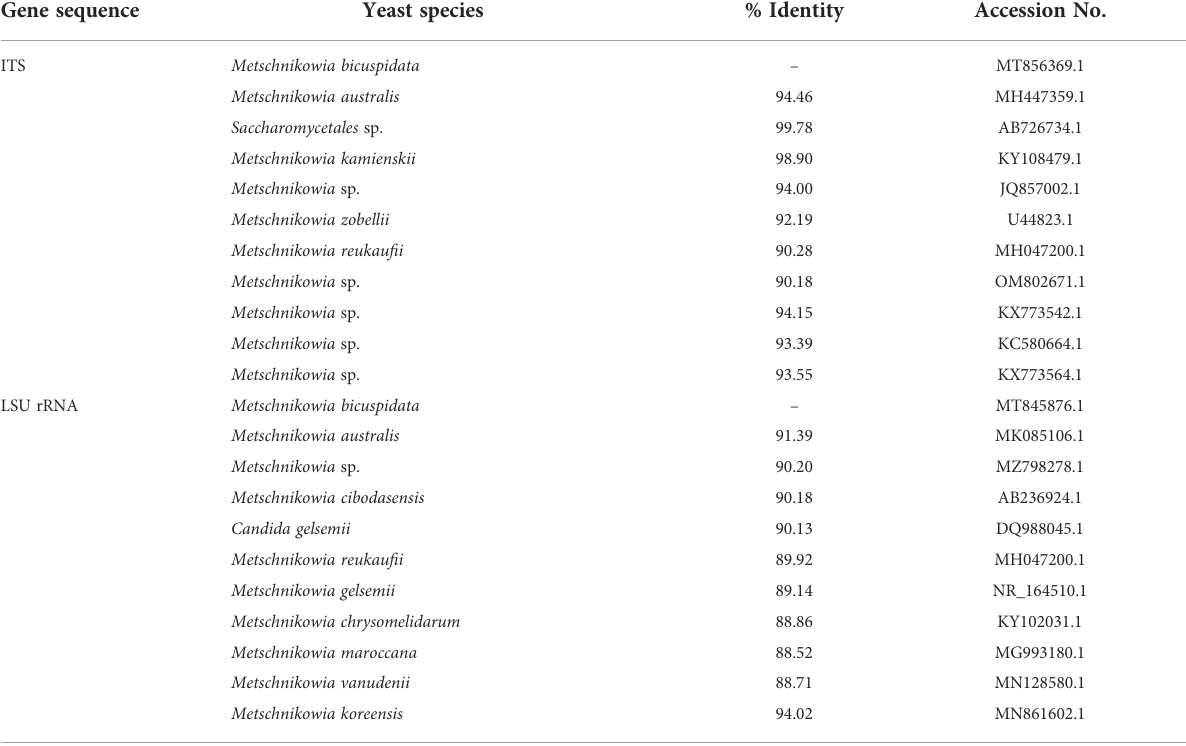
TABLE 1 Multiple sequence alignment analysis of target gene sequence for detection of Metschnikowia bicuspidata . Gene sequence Yeast species %